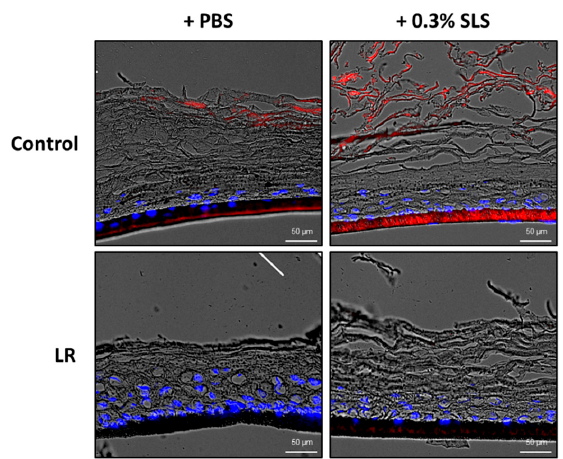
Figure 6. Effects of LR on the skin penetration of rhodamine B. Permeability of rhodamine B was evaluated after 24 h treatment of LR with or without SLS pretreatment. The fluorescent images represented rhodamine B (red), DAPI staining (blue).